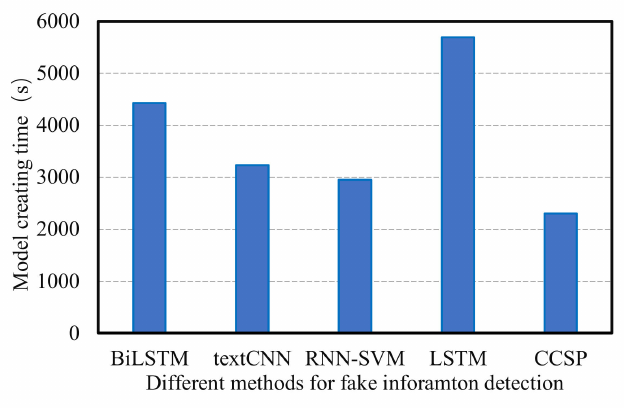
Figure 2. Model training or creating